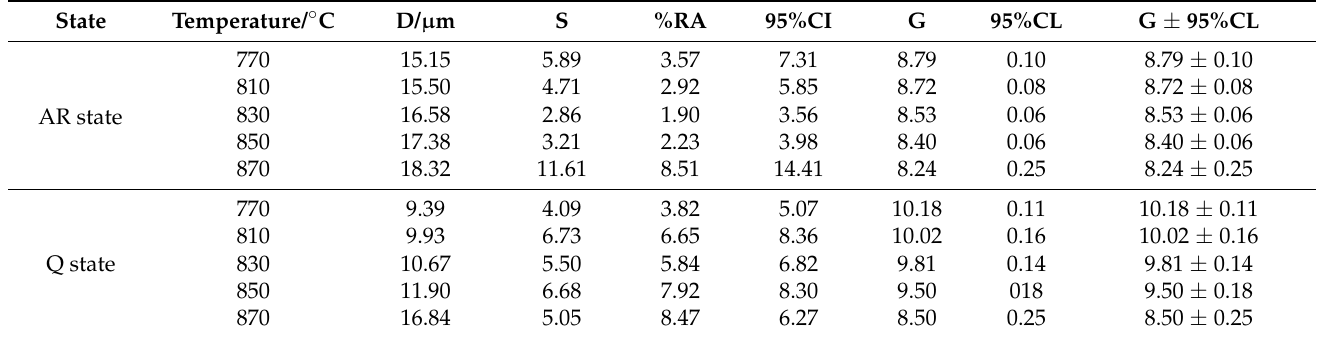
Figure 4. Austenite grain growth curve of AR and Q state samples: ( a ) AR state 770 °C, ( b ) Q state 770 °C, ( c ) AR state 810 °C, ( d ) Q state 810 °C, ( e ) AR state 830 °C, ( f ) Q state 830 °C, ( g ) AR state 870 °C, and ( h ) Q state 870 °C. Table 2. Austenite grain sizes and grades of the steel at different heating